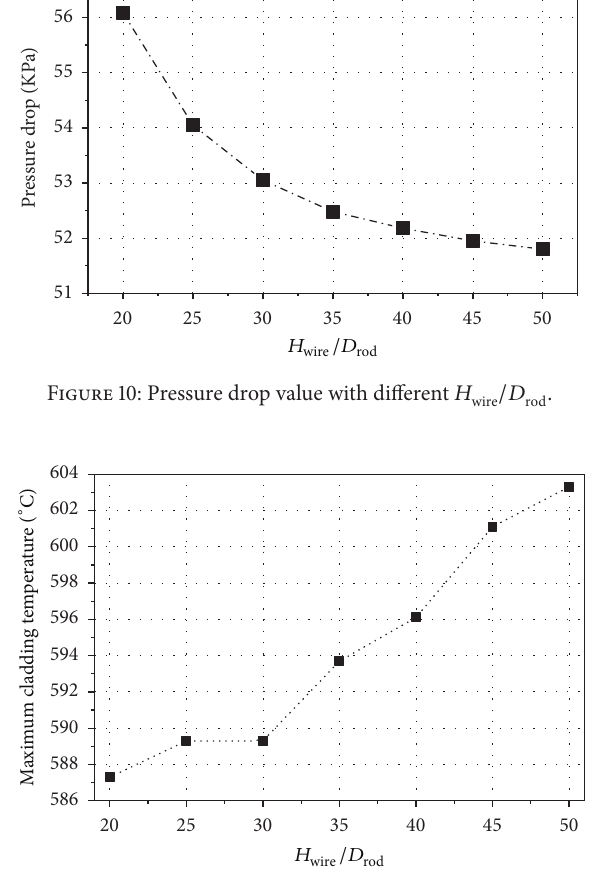
Figure11:Thepeakcladdingtemperaturecomparisonwithdifferent /𝐷 𝐻 wire rod /𝐷 wire rod